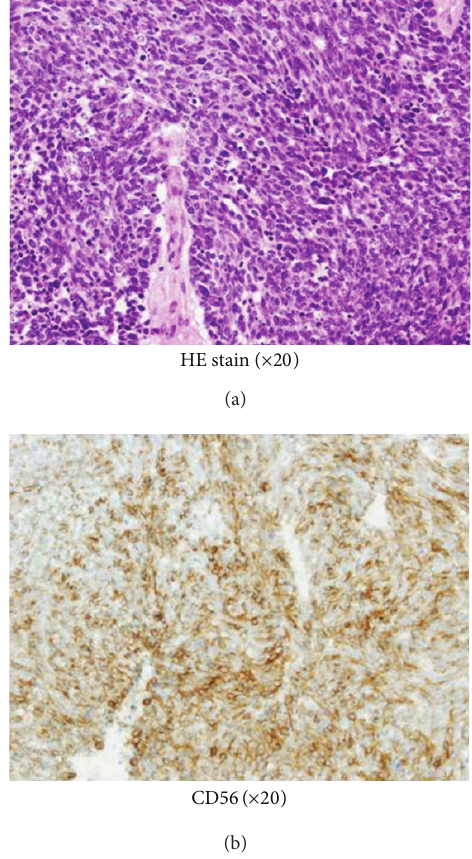
Figure 3: (a) Infiltrative, proliferative tumor that had formed vari- ous large and small solid cancer nests. (b) Results of CD56 staining were